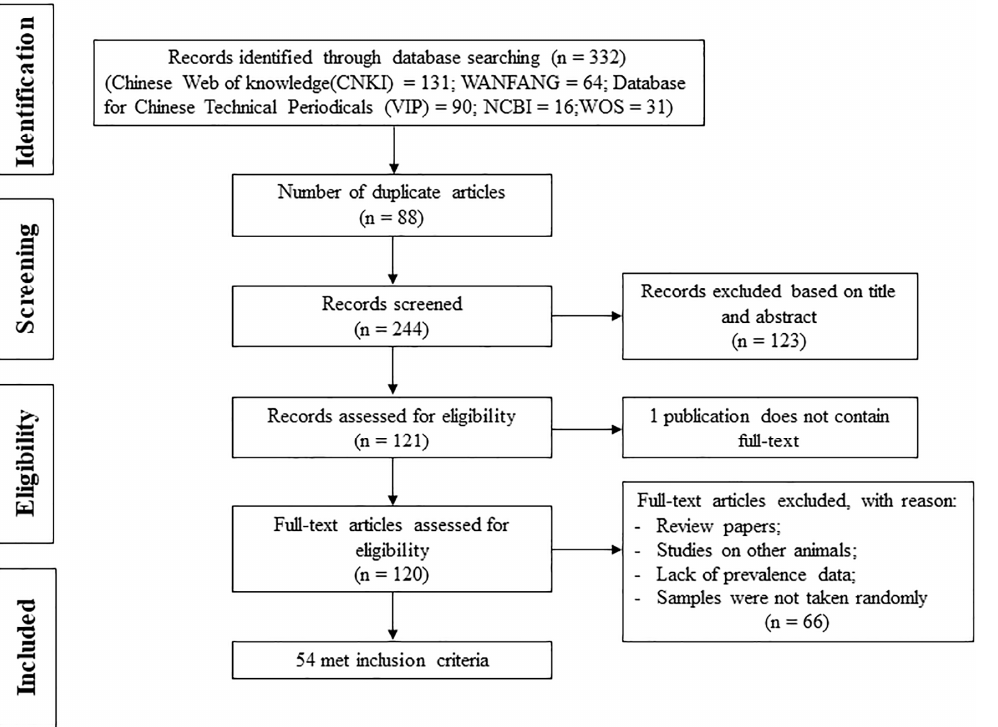
Figure 1. PRISMA flowchart of the systematic review and meta-analysis process shows the inclusion and exclusion of studies.